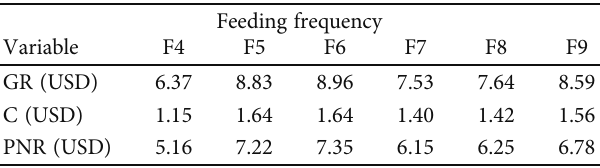
Figure 3: Principal component analysis (PCA) graph of variables. Graph with the vectors of the variables used in the study and main components 1 and 2, dim 1 and dim 2, respectively, the arrows indicate the load of the parameters in the two axes. HSR: hepatosomatic relation; AFC: apparent feed conversion; FI: feed intake; TP: total phosphorus; WG: weight gain; TN: total nitrogen; SL: standard length; TL: total Table 7: Gross revenue (GR), costs (c), and partial net revenue (PNR) in the feed frequencies.